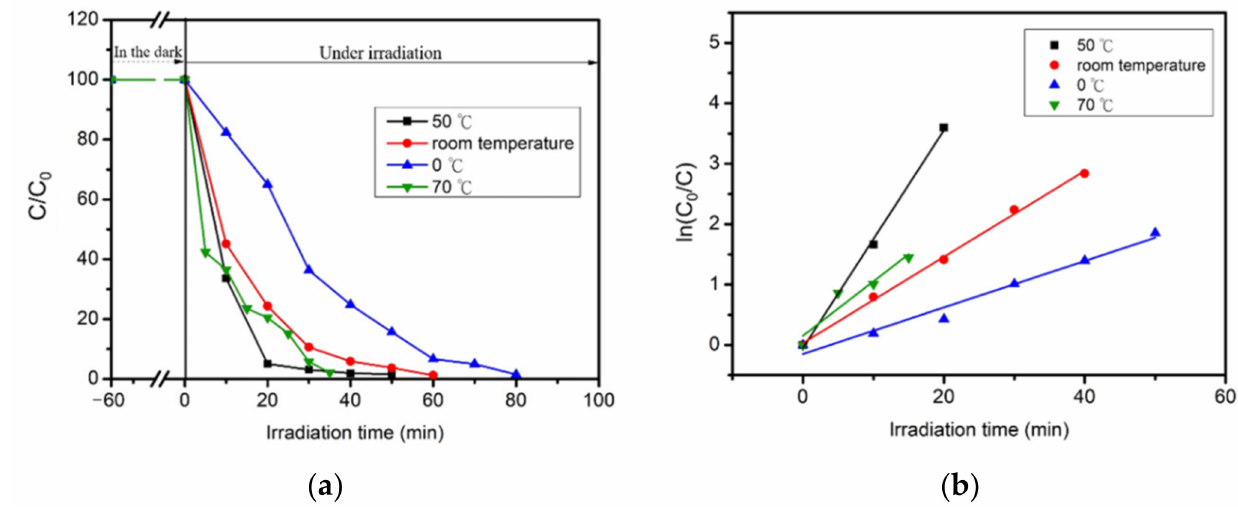
Figure 7. ( a ) Photodegradation of bare TiO 2 at different reaction temperatures; ( b ) photocatalytic activities of TiO 2 different reaction temperatures by plotting ln(C 0 /C) versus irradiation time